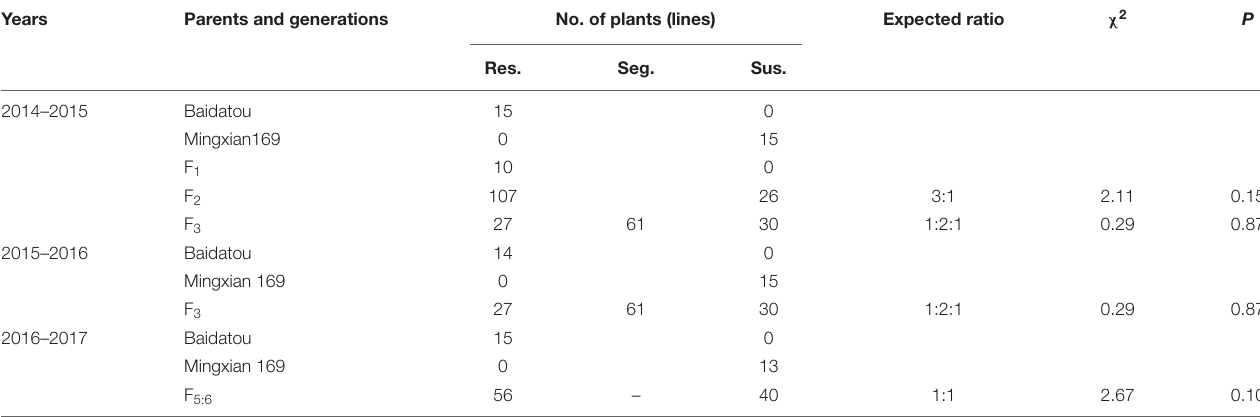
Years Parents and generations No. of plants (lines) Expected ratio χ 2 P Res. Seg.